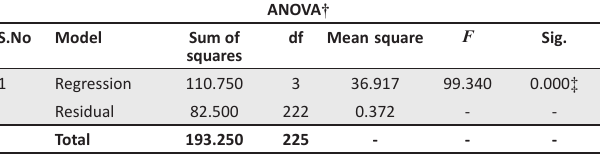
TABLE 3b: Multiple regression analysis.